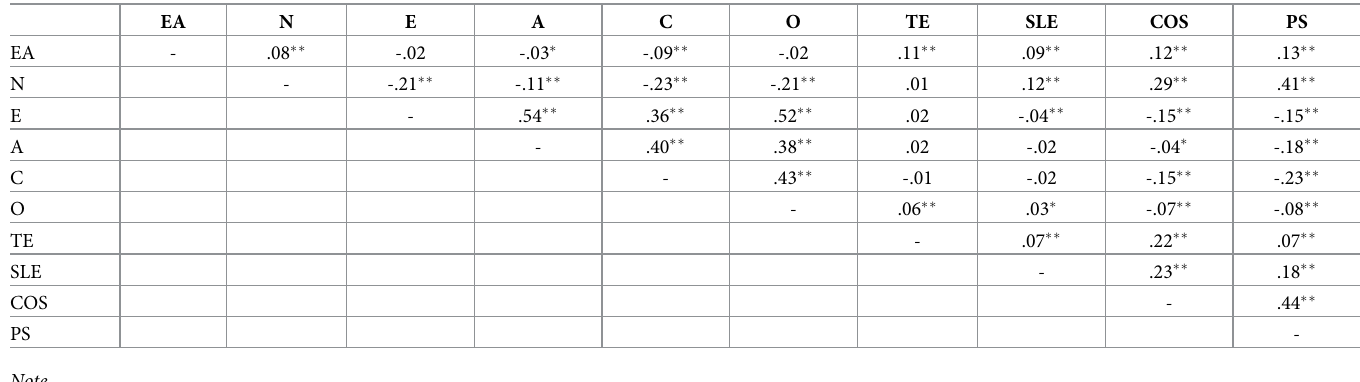
Table 1. Correlations among manifest variables in the HRS sample.